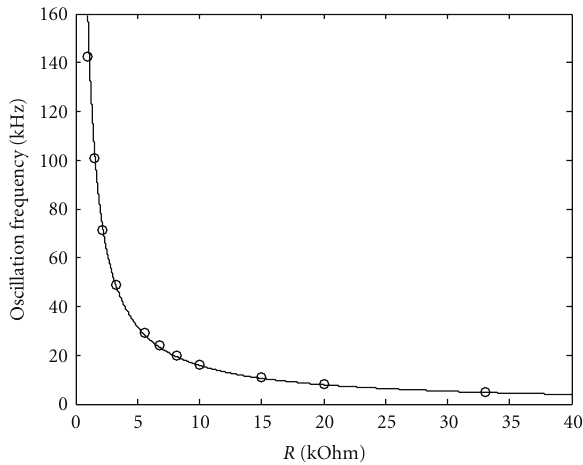
Figure 4: Experimental results of the oscillation frequency of Figure 1, which is obtained by varying the value of R; ooo, experi- mental results; —, ideal curve.